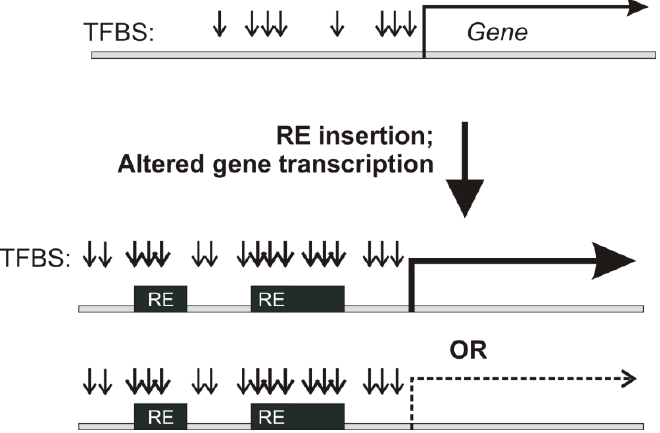
Figure 1. RE insertion in the proximity of transcription start sites can bring new TFBS and drastically alter gene expression.